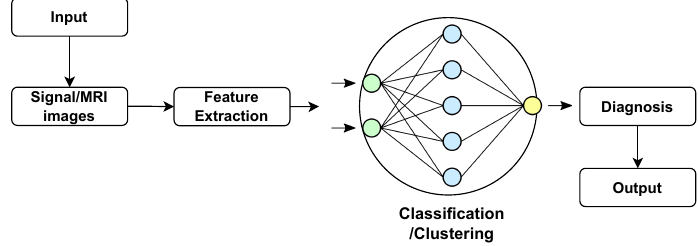
Figure 3. Representation of common machine learning